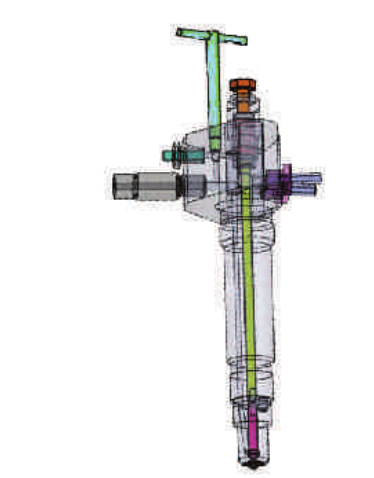
Fig. 6. Edge geometric model of the injector of the investigated engine